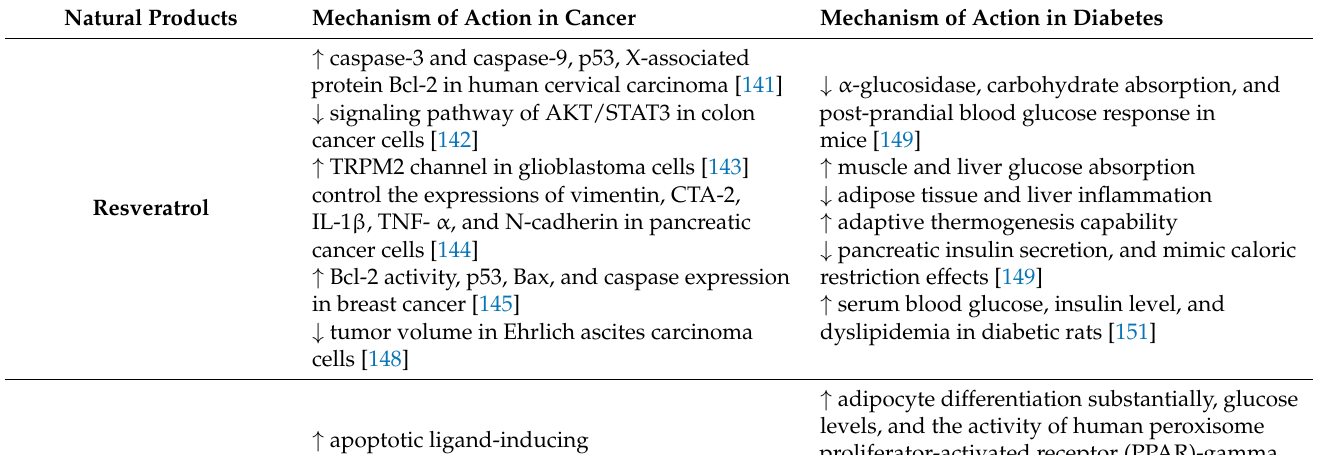
Table 2. Antidiabetic and anticancer activity of some natural products that have the ability to treat both diseases. Natural